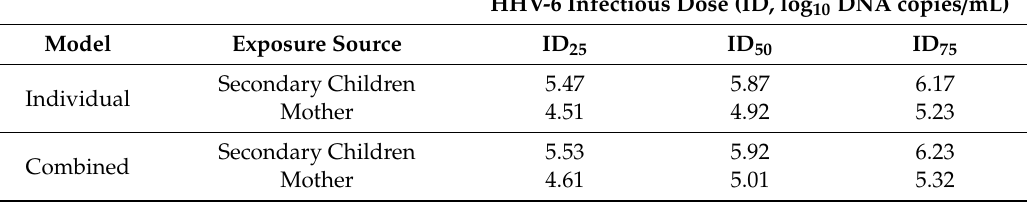
Table 3. HHV-6 weekly infectious exposure (ID, log 10 DNA copies / mL) associated with 25%, 50%, and 75% probability of infection (ID 25 , ID 50 , and ID 75 ) estimated from the HHV-6 risk models by exposure source. For the exposure combined model, calculations assume a single exposure source. Exposure was not associated with CMV transmission and so IDs were not